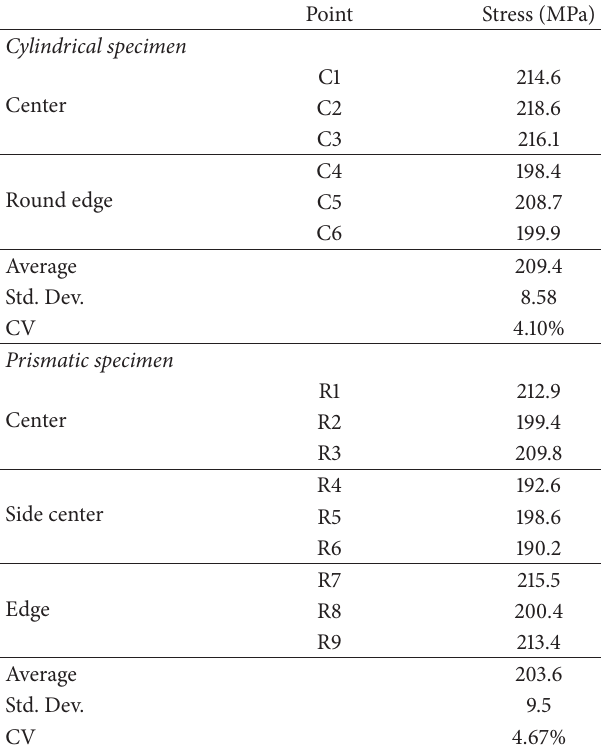
Table 3: Analysis of the peak stress of the selected elements in the cylindrical and prismatic specimens by numerical